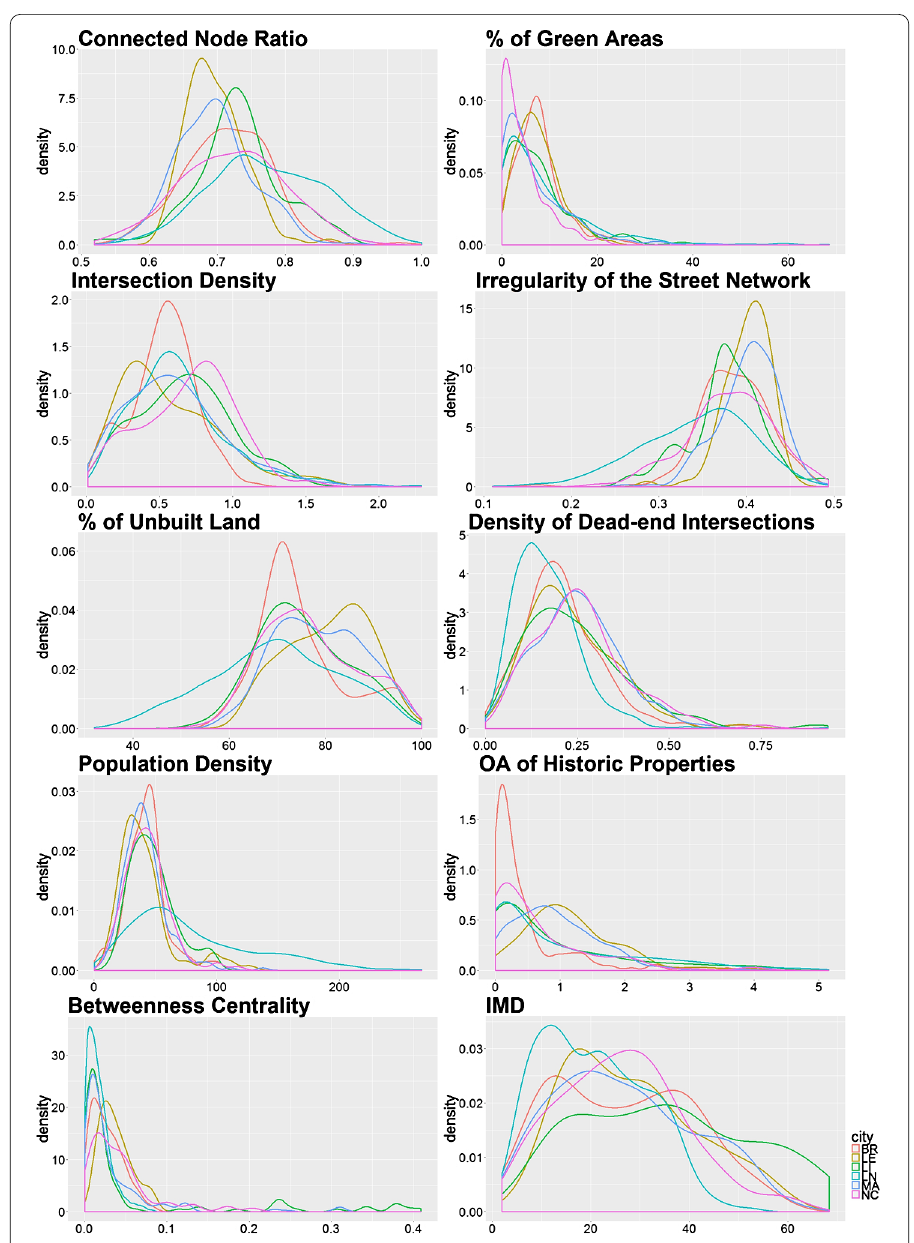
Figure 2 Density distribution plots for the metrics of urban form and IMD, for the six cities. BR: Birmingham. LN: London. MA: Manchester. LE: Leeds. LI: Liverpool. NC: Newcastle